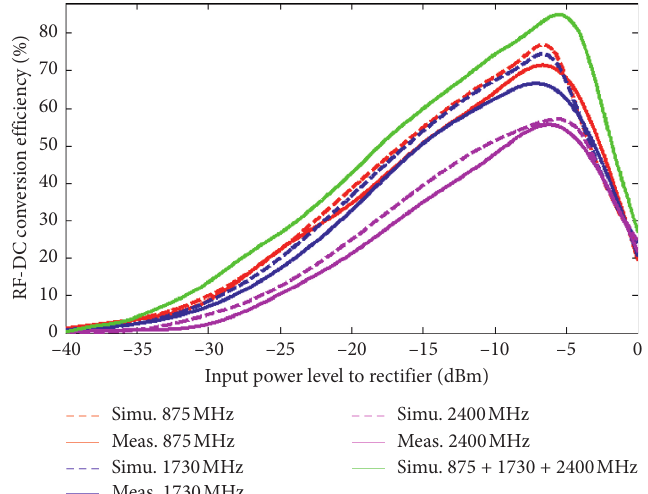
Figure 25: RF-DC conversion efficiency of the triband rectifier for 10k Ω load.